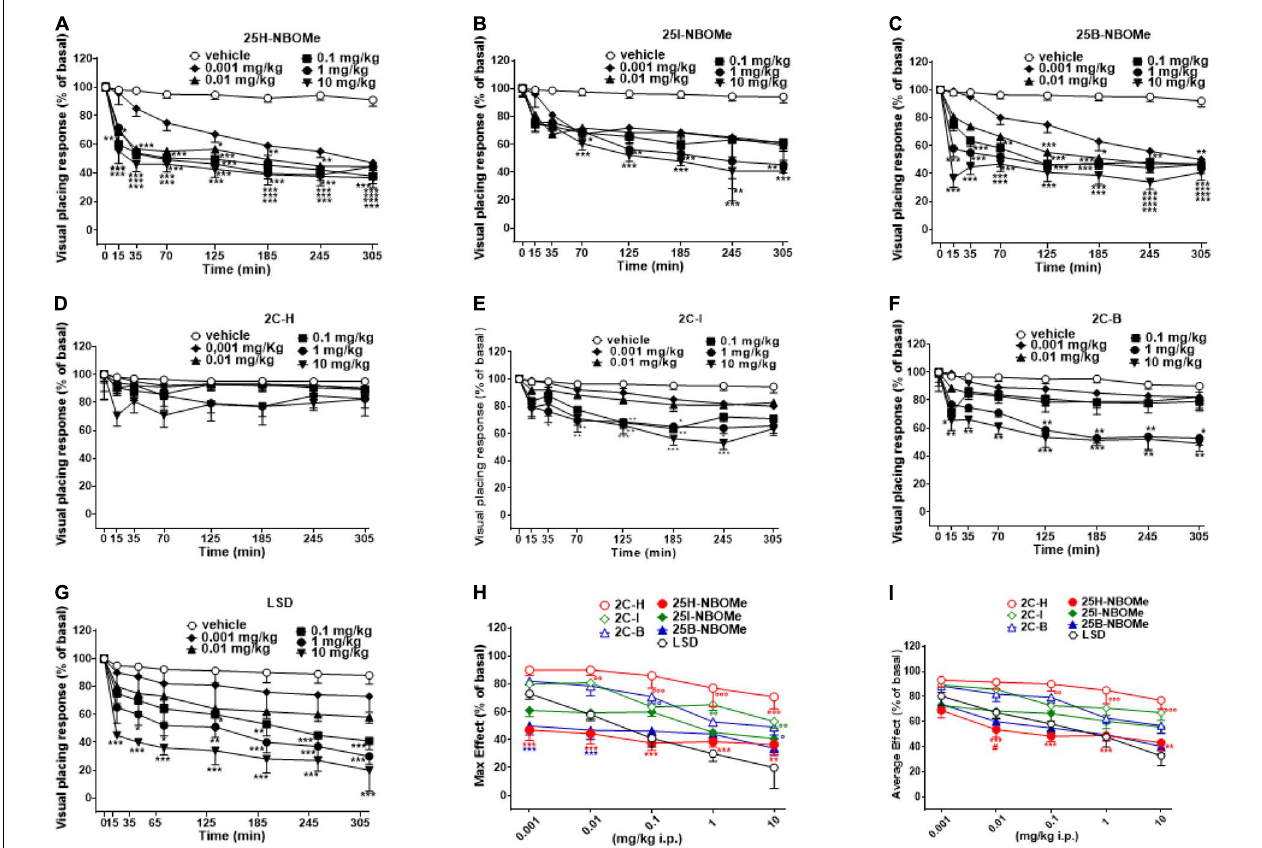
FIGURE 3 | Effect of 25H-NBOMe (0.001–10 mg/kg i.p.) (A) 25I-NBOMe (0.001–10 mg/kg i.p.) (B) 25B-NBOMe (0.001–10 mg/kg i.p.) (C) 2C-H (0.001–10 mg/kg i.p.) (D) 2C-I (0.001–10 mg/kg i.p.) (E) 2C-B (0.001–10 mg/kg i.p.) (F) and LSD (0.001–10 mg/kg i.p.) (G) on the visual placing tests in the mice and comparison of the maximum (H) and average (I) effect observed in 5 h. Data are expressed as mean ± SEM ( n = 8/group). Statistical analysis was performed by two-way ANOVA followed by Bonferroni’s test (A–G) for multiple comparisons for the dose–response curve of each compound at different time points. The comparison of maximum effect observed in 5 h was also presented (H,I) . * p < 0.05, ** p < 0.01, *** p < 0.001 vs. vehicle; # p < 0.05 vs.